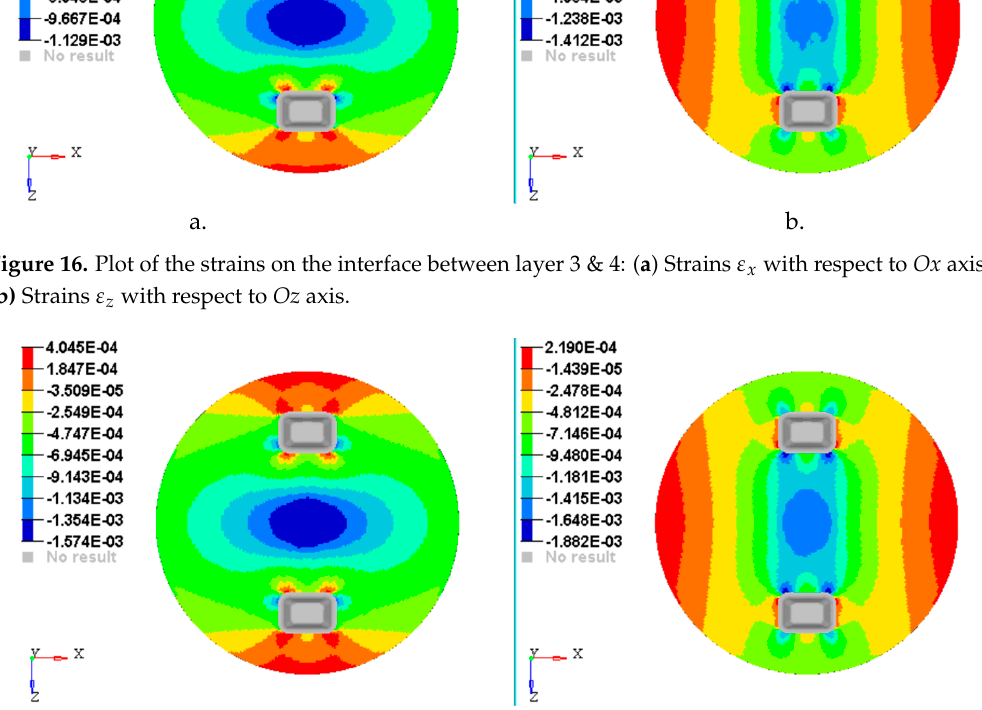
a. b. Figure 17. Plot strain on the interface between layer 4 and 5: ( a ) Strains ε x with respect to Ox axis; Figure 17. Plot strain on the interface between layer 4 and 5: ( a ) Strains x ε with respect to ( b ) strains ε z with respect to Oz Ox axis; ( b ) strains z ε with respect to Oz axis.